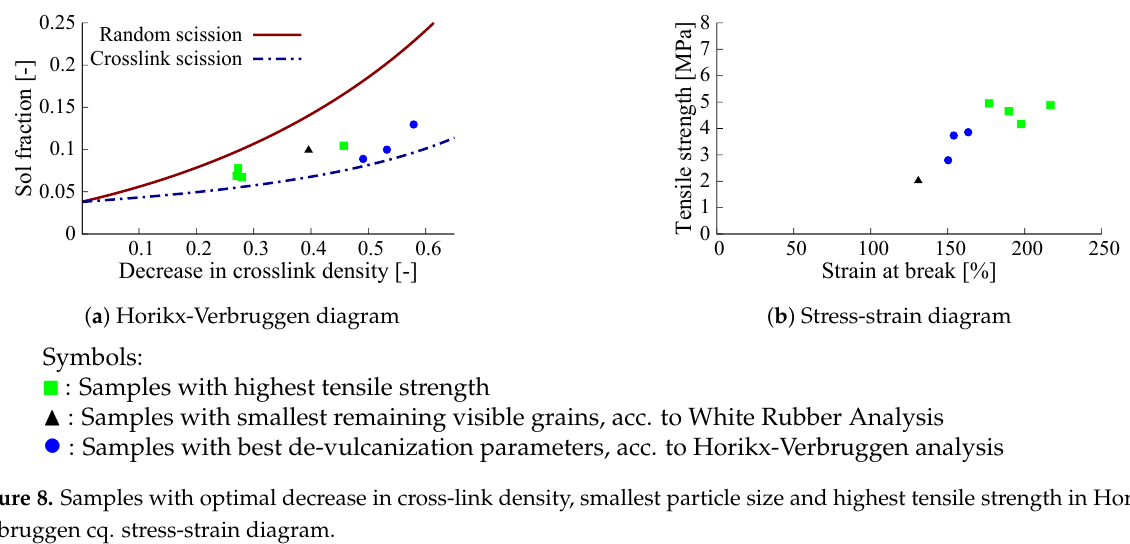
Figure 7. Preliminary de-vulcanization data presented as both, Horikx-Verbruggen points and stress-strain at break points after having been re-vulcanized using the CB -based formulation given in Table A1, Appendix A.1.